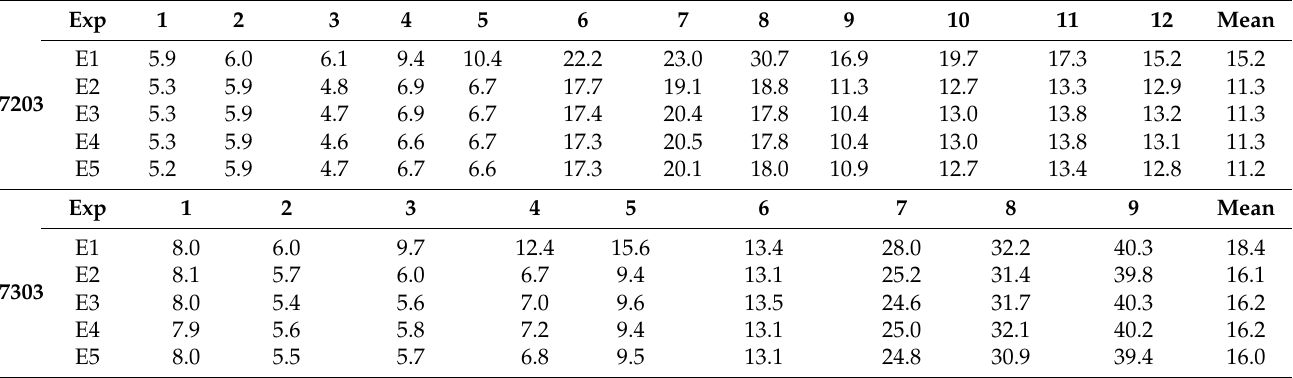
Table 4. Root–mean–square errors between simulated and observed storm surge levels in each 6-h period during Typhoons 7203 and 7303 (unit: cm).